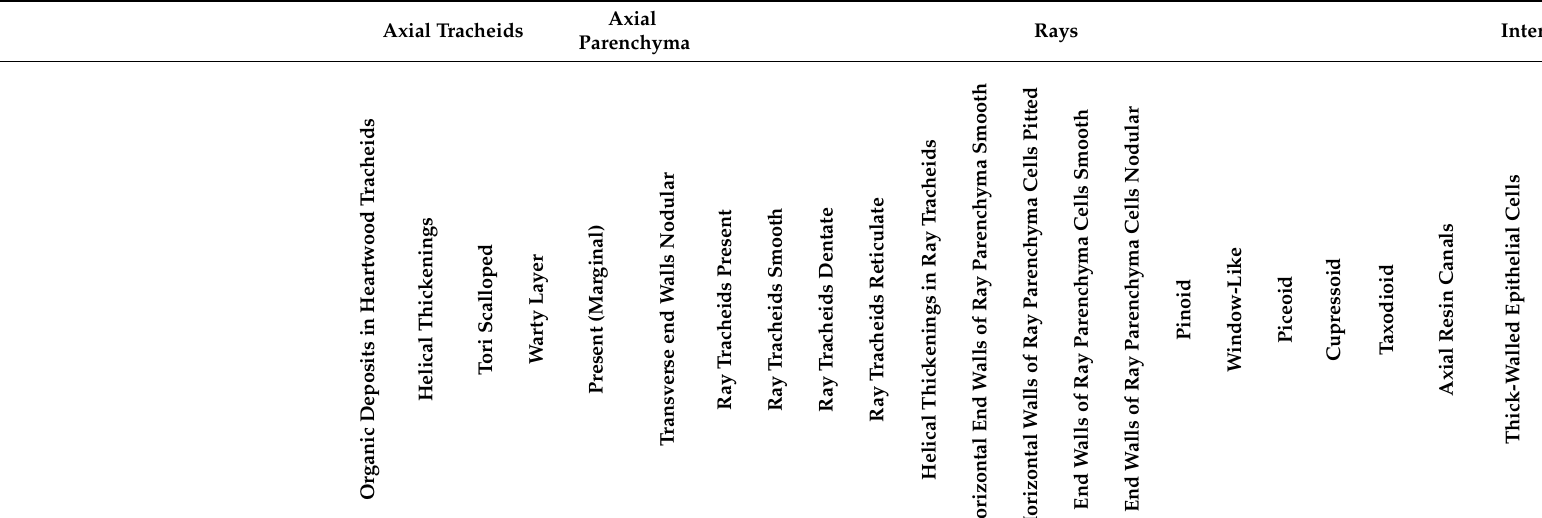
Table A1. Features observed in the species studied. + Present, − Absent,